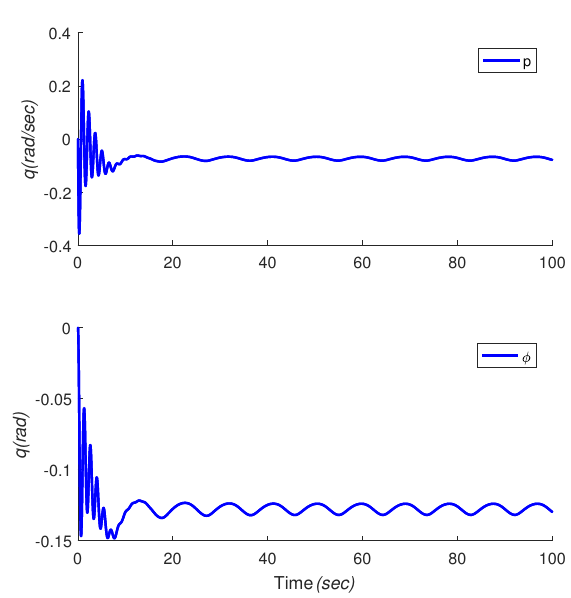
Figure 3. Roll angle φ and rate p of REMUS in six DOF model simulation.